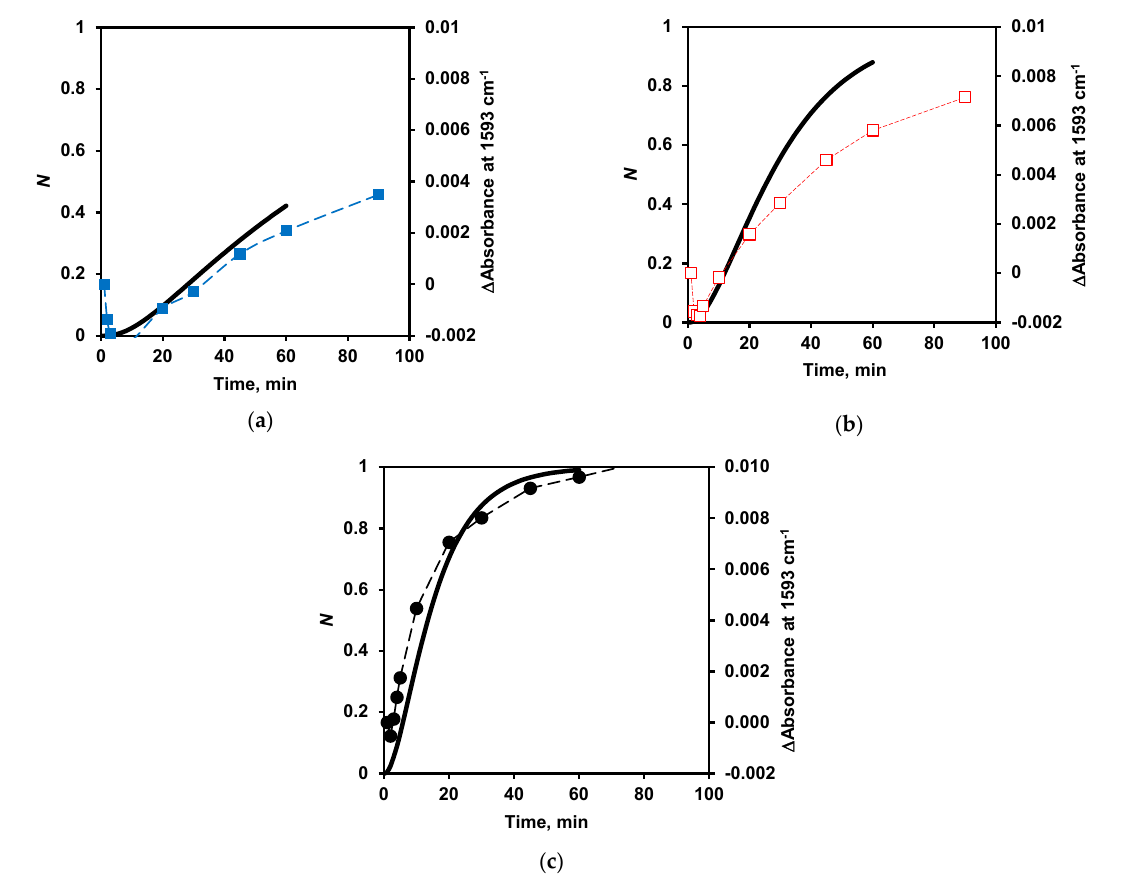
Figure 9. Yield of proteolysis products N ( t ) according to the model (solid line) at S 0 / E 0 ratios of 1000 ( a ), 250 ( b ), and 63 ( c ) and FTIR data (dotted line) at S 0 / E 0 ratios of 10,000 ( a , ■ , blue), 4000 ( b , □ , red), and 500 ( c , ● , black).